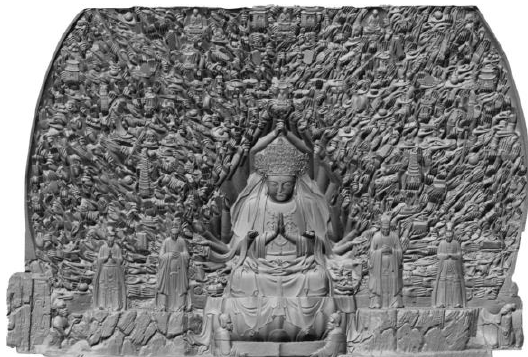
Figure 4. 3D Model The Dazu Thousand-hand Bodhisattva